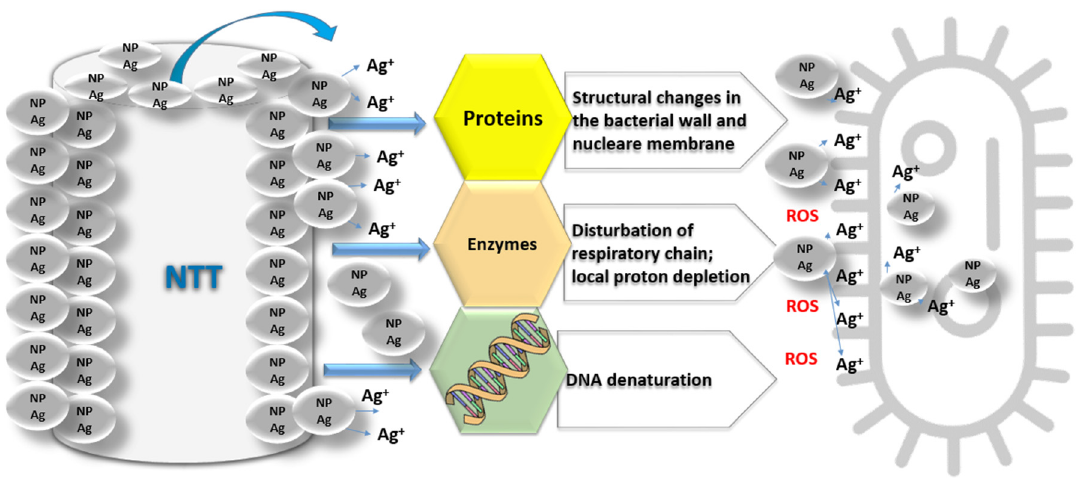
Figure 1. The proposed mechanism of action of silver nanoparticles (NP Ag) released by titanium nanotubes (NTT).